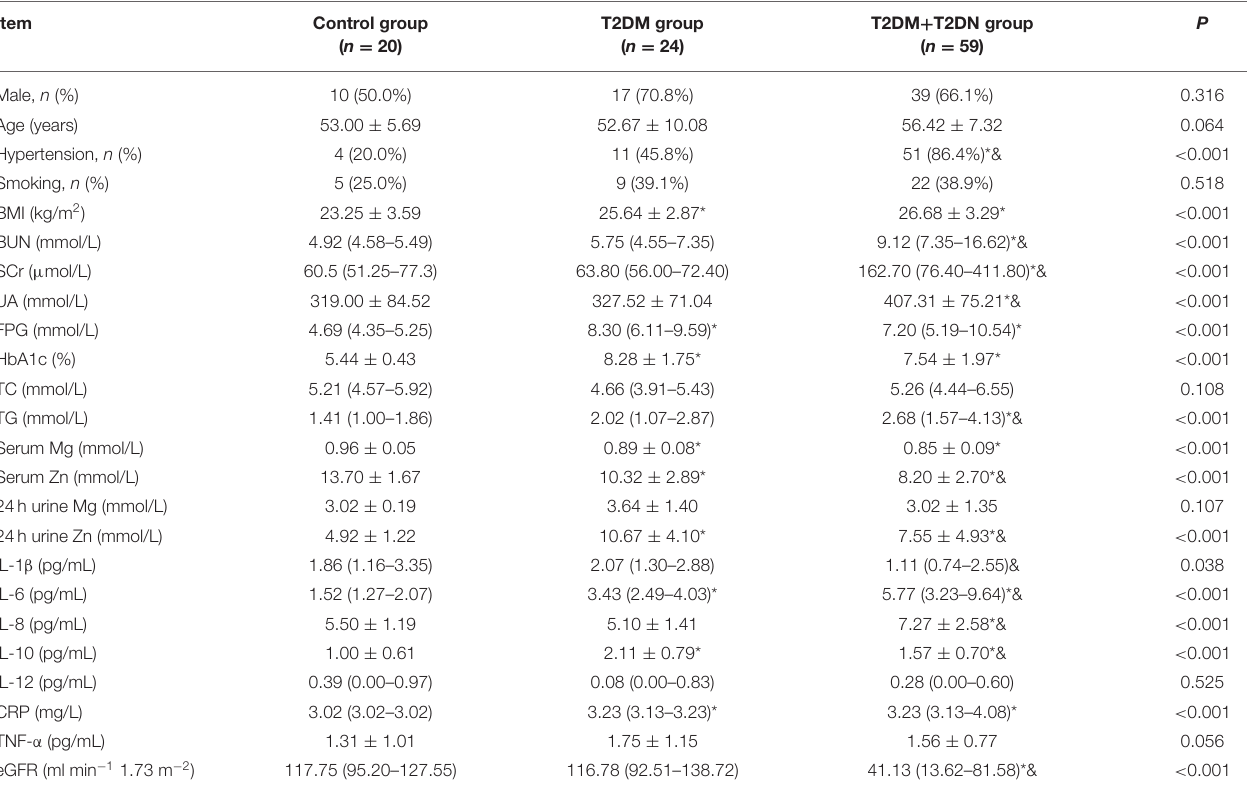
TABLE 1 | Demographic and biochemical parameters of the studied population with and without T2DM and T2DN. Item Control group ( n = 20)